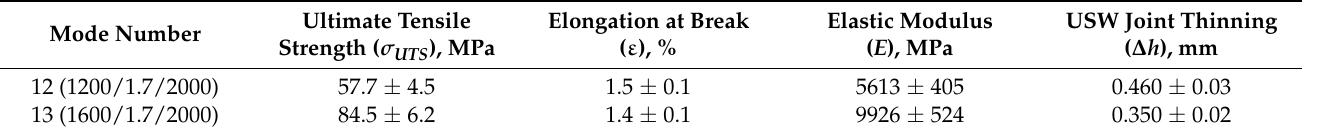
Table 9. The mechanical and dimensional properties of the USW lap joint obtained with modes 12, 13. Mode